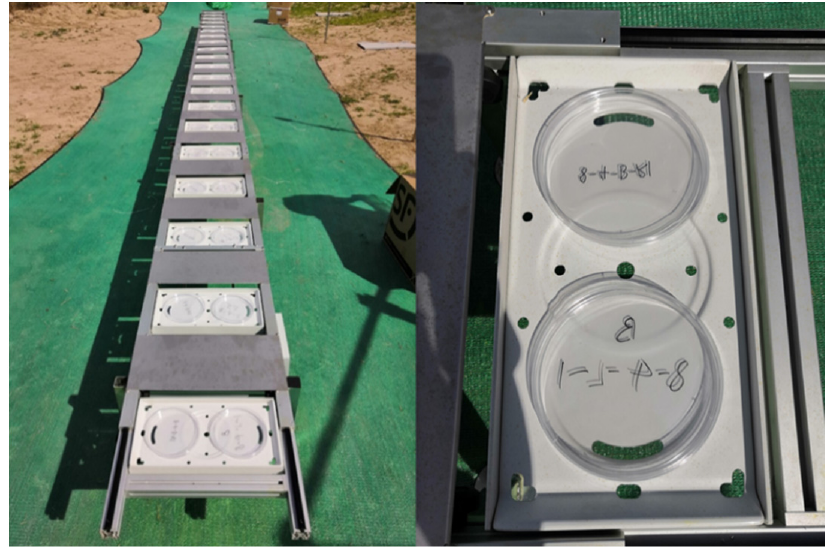
Figure 2. Field drift test bench and artificial collectors for UASS spray drift measurement.